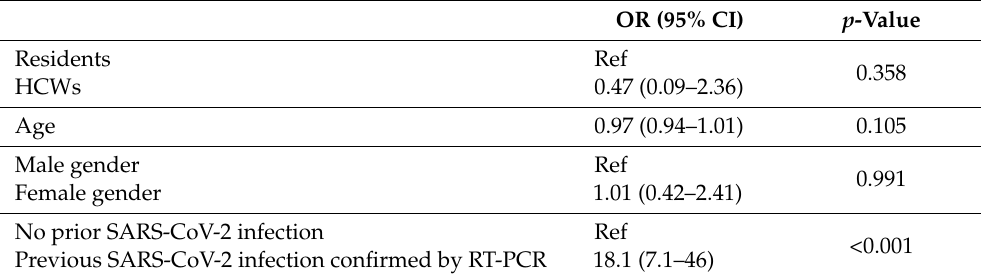
Table 4. Predictors of maintaining a significant antibody response 9 months after a full vaccination cycle with Pfizer/BNT162b2 SARS-CoV-2 mRNA vaccine among healthcare workers (HCWs) and residents of 13 long-term care facilities of Piedmont, Italy,